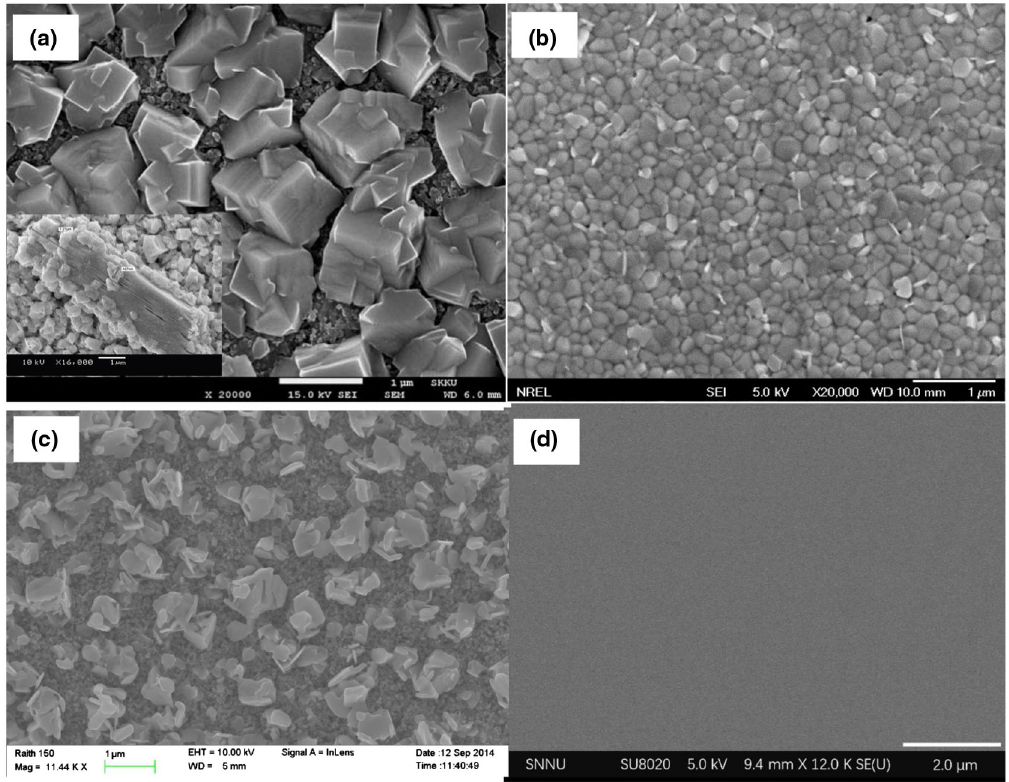
FIG. 1. SEM images of MAPbI 3 hybrid perovskite samples: (a) a SKKU-p sample (with a large domain shown as an inset), (b) a NREL-p sample, (c) a degraded SKKU-p sample, (d) a SNU-c